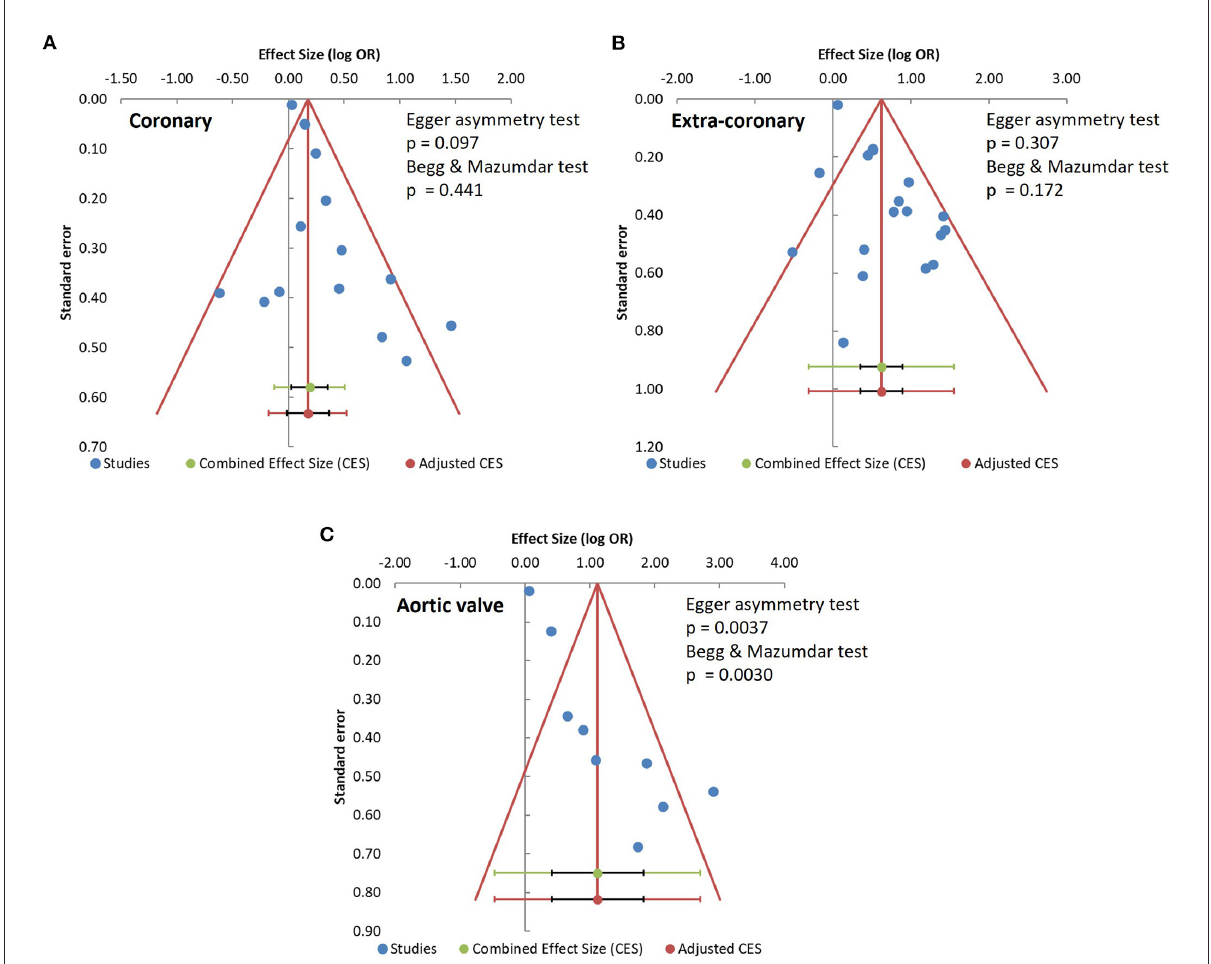
FIGURE3 Analysis of publication bias. (A) coronary artery calcification; (B) extra-coronary calcification; (C) aortic valve calcification